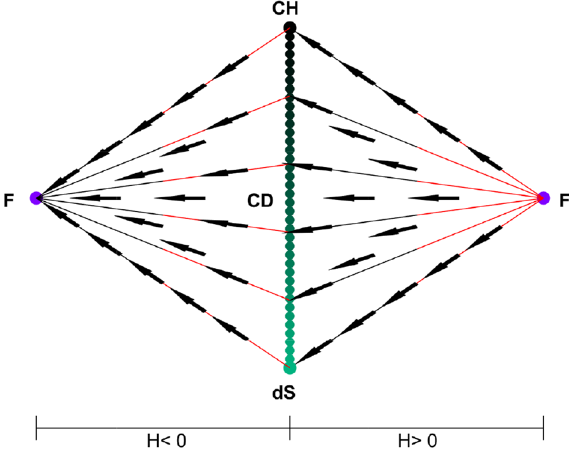
Figure 5. The flat submanifold. Neither γ nor α changes the structure of it. Here, dots denote the solutions of the system; F, dS, CH and CD represent Flat FL solution (� solution (� Chaplygin-de Sitter solution line